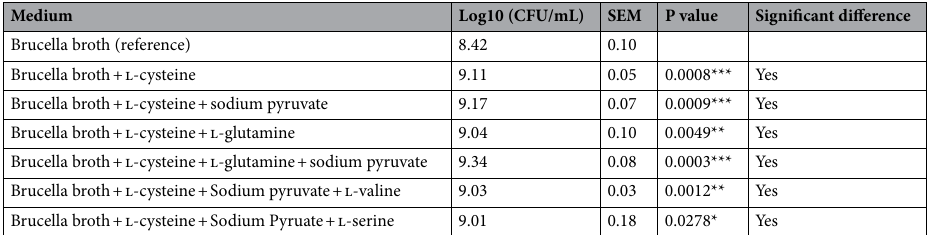
Medium Log10 (CFU/mL) SEM P value Significant